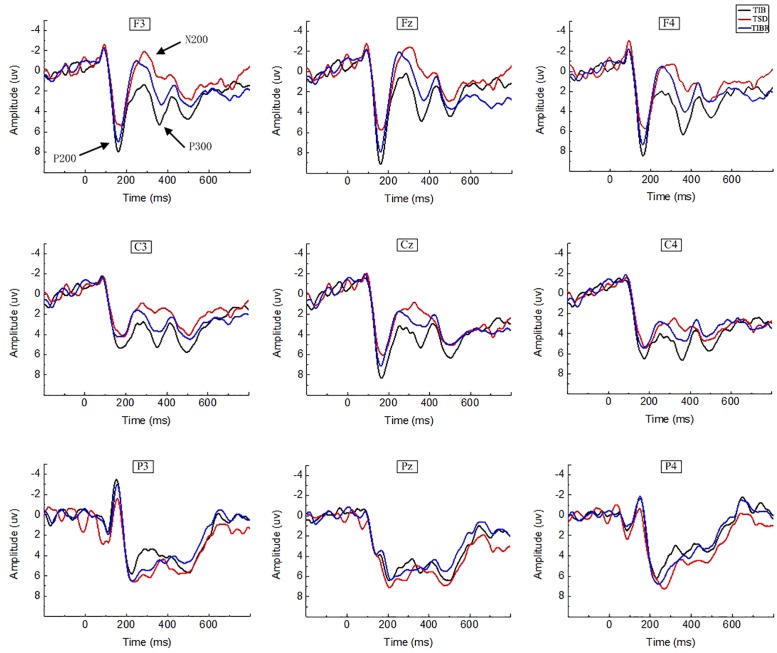
ERP amplitude between sleep conditions for the Mismatching stimuli in working memory. Grand-average ERP (P200, N200, and P300) in the Mismatching stimuli condition across multiple electrode sites after 8 h time in bed (TIB), after 36 h of total sleep deprivation (TSD), and after 8 h time in bed for recovery (TIBR). The channels are ordered left-right and top-bottom as follows: F3, Fz, F4, C3, Cz, C4, P3, Pz, and P4.